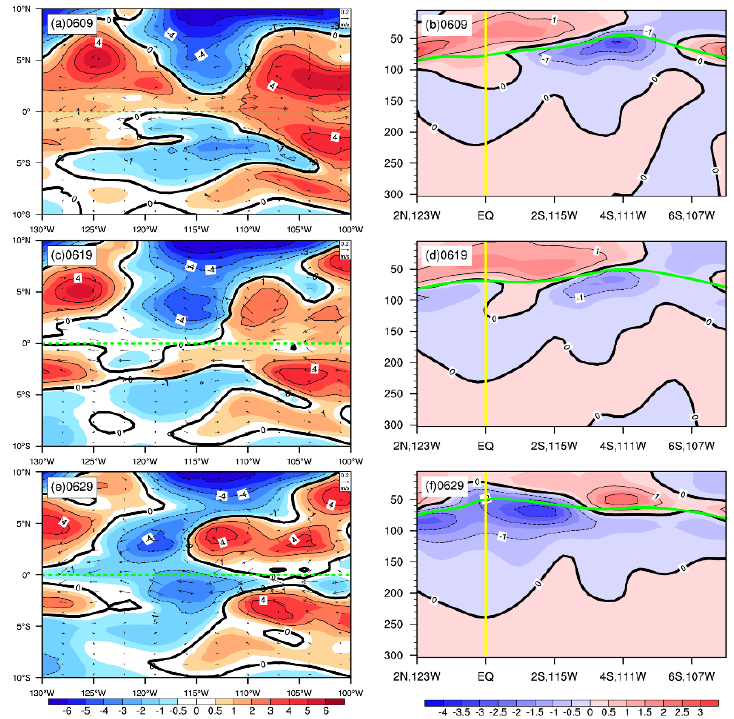
Figure 9. The spatial distribution of the temperature and ocean current anomalies evaluated at the thermocline depth over the central-eastern Pacific (10 ◦ S–10 ◦ N, 130 ◦ W–100 ◦ W) in the pentad- averaged periods of June 2021 ( a , c , e ). The green line marks the equator ( left ). Zonal-depth sections of the temperature anomalies (the upper 300 m) from (2 ◦ N, 123 ◦ W) to (7 ◦ S, 105 ◦ W) in the pentad- averaged area of June 2021 ( b , d , f ). The green and yellow lines mark the thermocline depth and equator, respectively ( right ). Units: ◦ C for temperature; m s − 1 for